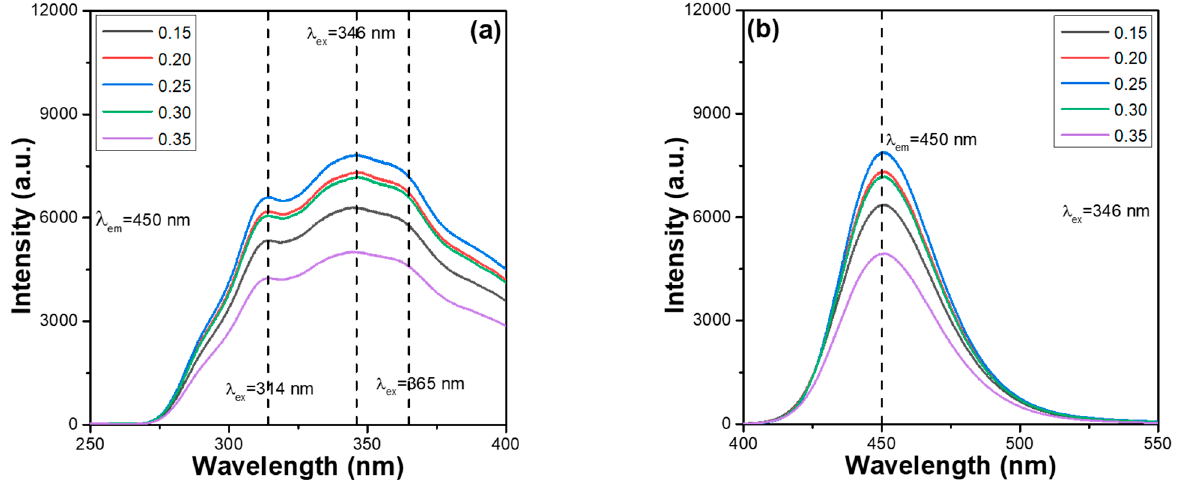
Figure 1. ( a ) PLE spectra of CaMgSi 2 O 6 :yEu 2+ phosphors, and ( b ) PL spectra of CaMgSi 2 O 6 :yEu 2+ phosphors.